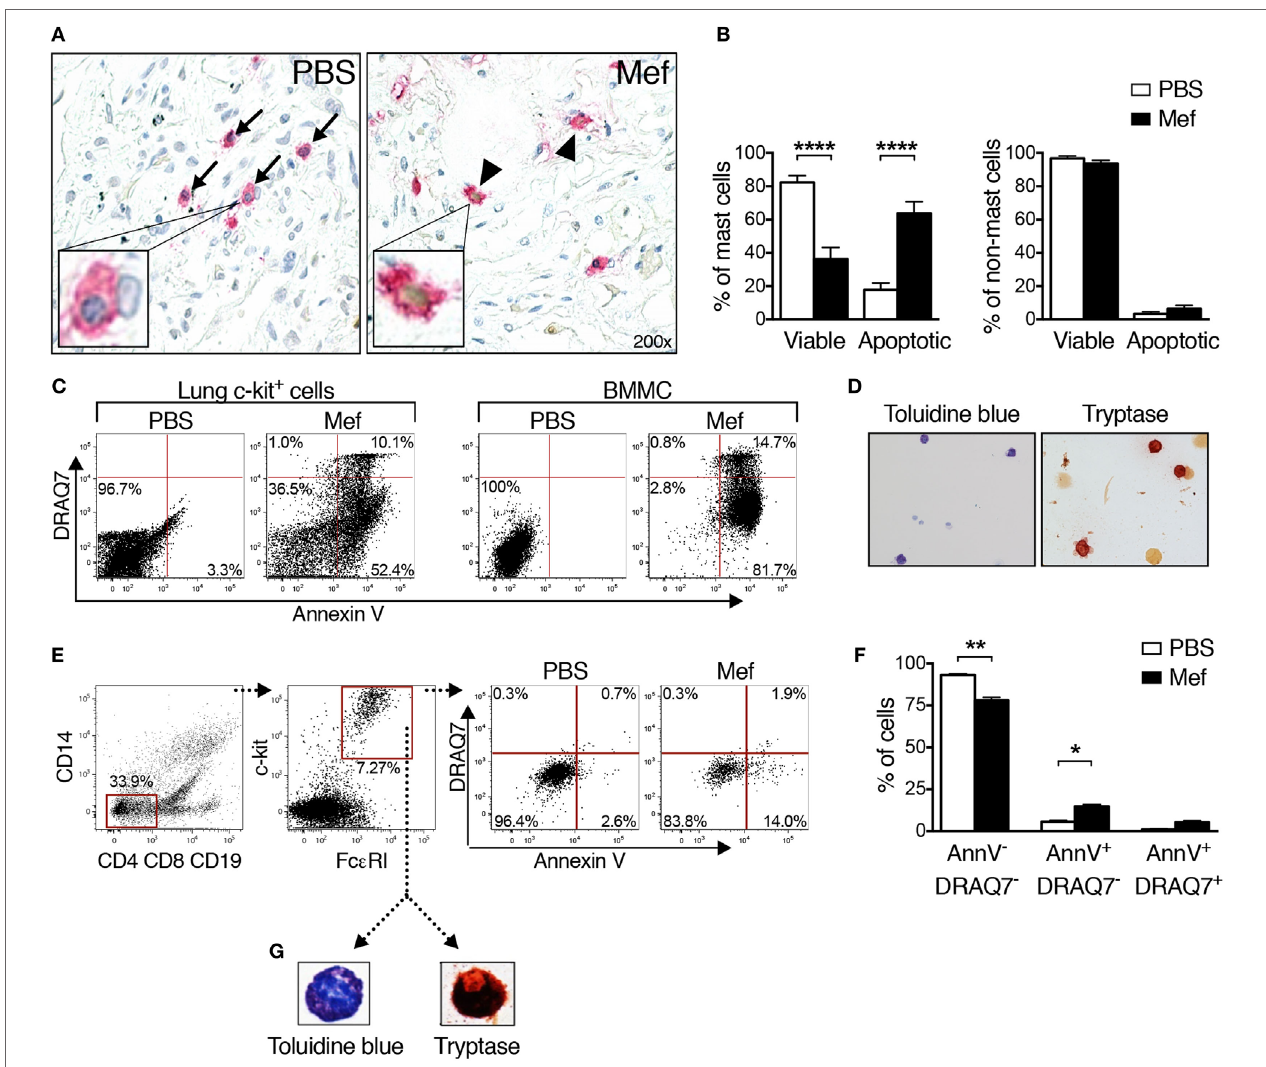
FigUre 2 | Mefloquine induces apoptotic cell death in human lung mast cells. Human lung specimens were incubated with mefloquine (Mef; 20 µM) or phosphate- buffered saline (PBS) for 20 h. TUNEL-tryptase double staining was performed on cross sections of the lung biopsies followed by nuclear counterstaining with Mayer’s hematoxylin. (a) Representative images of lung sections showing the reduction in the number of viable mast cells (TUNEL − /tryptase + , blue nucleus with pink cytoplasm, arrows) and increase in the number of apoptotic mast cells (TUNEL + /tryptase + , brown nucleus with pink cytoplasm, arrowheads). The inserts in panel A show enlarged images of viable (left) or apoptotic (right) mast cells. (B) Percentage of viable (TUNEL − /tryptase + ) and apoptotic mast cells (TUNEL + /tryptase + ) (left panel, n = 20; representative of two independent experiments/two donors) and percentage of viable (TUNEL − /tryptase − ) and apoptotic non-mast cells (TUNEL + / tryptase − ) (right panel, n = 4; representative of two independent experiments/two donors) in the lung tissue after treatment with PBS or mefloquine. Results are shown as mean ± SEM (**** P < 0.0001). (c) Mixed human lung cells were prepared by mechanical and enzymatic treatment of lung specimens and c-kit + cells were enriched by magnetic-activated cell sorting. Human lung c-kit + cells or murine cultured mast cells [bone marrow-derived mast cells (BMMCs); used as controls] were treated with mefloquine (20 µM) or PBS for 24 h. Cells were stained with Annexin V and DRAQ7 and cell death was assessed by flow cytometry. Representative dot plots in panel (c) display the Annexin V/DRAQ7 staining of human lung c-kit + cells (left) and BMMCs (right) after treatment with PBS or mefloquine. The results in panel (c)